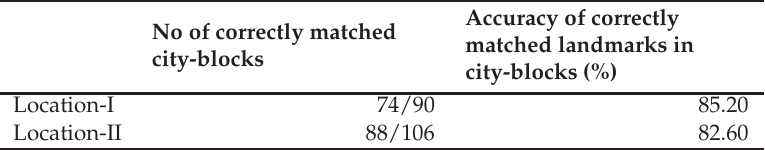
Table 2: The accuracy rates of correctly matched landmarks in the matched city-blocks using the constraints from multiple sketch